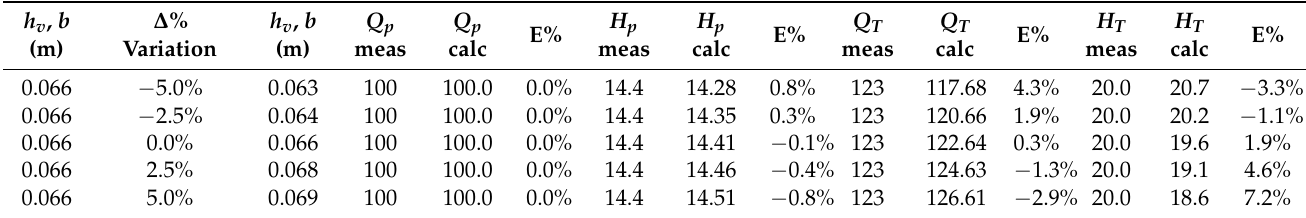
Table 10. Sensitivity analysis for pump